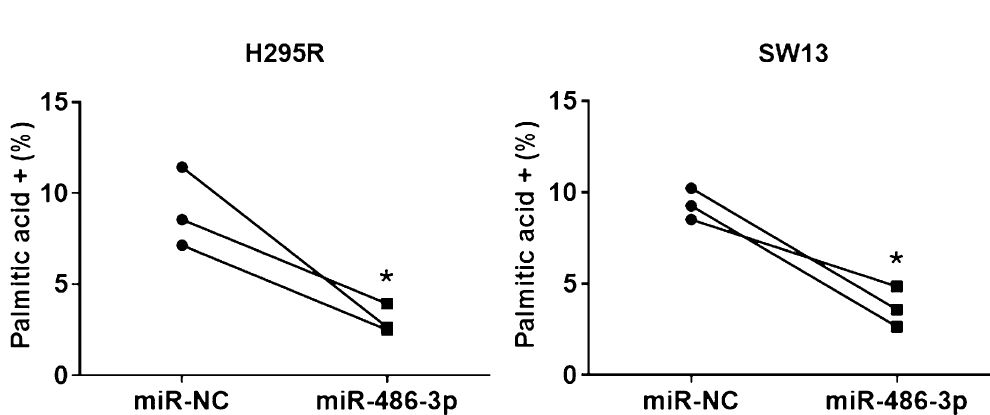
Figure 8. Palmitic acid detection by using flow cytometry assay. Palmitic acid levels were significantly (< 0.05) inhibited in both H295R as well as SW13 cells transfected with miR-486-3p mimic compared to corresponding cells transfected with miR-NC. The experiments were performed three